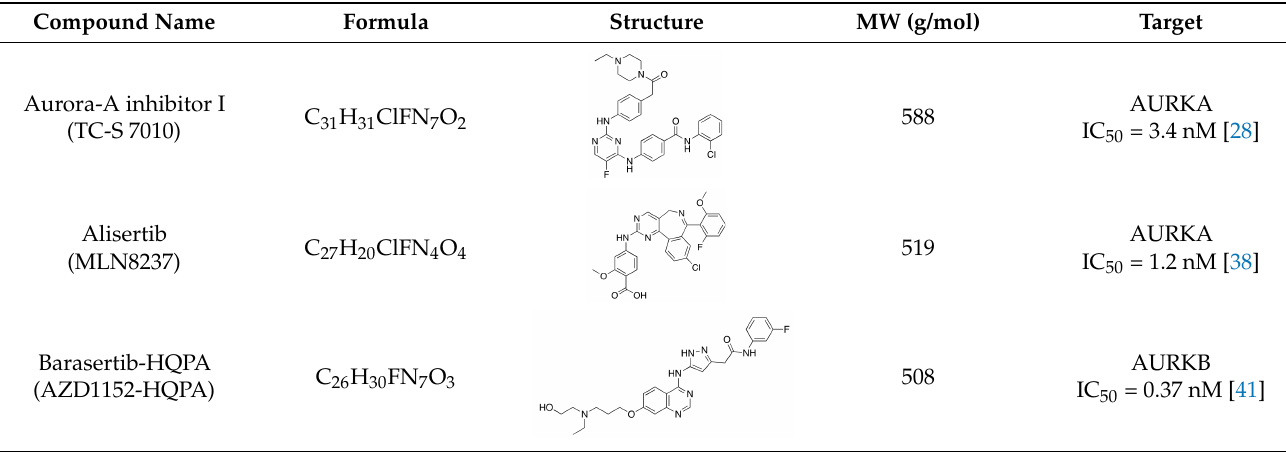
Table 1. AURKA and AURKB inhibitors used in this